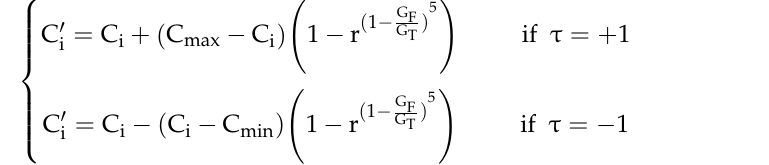
Figure 10. The arithmetic crossover.